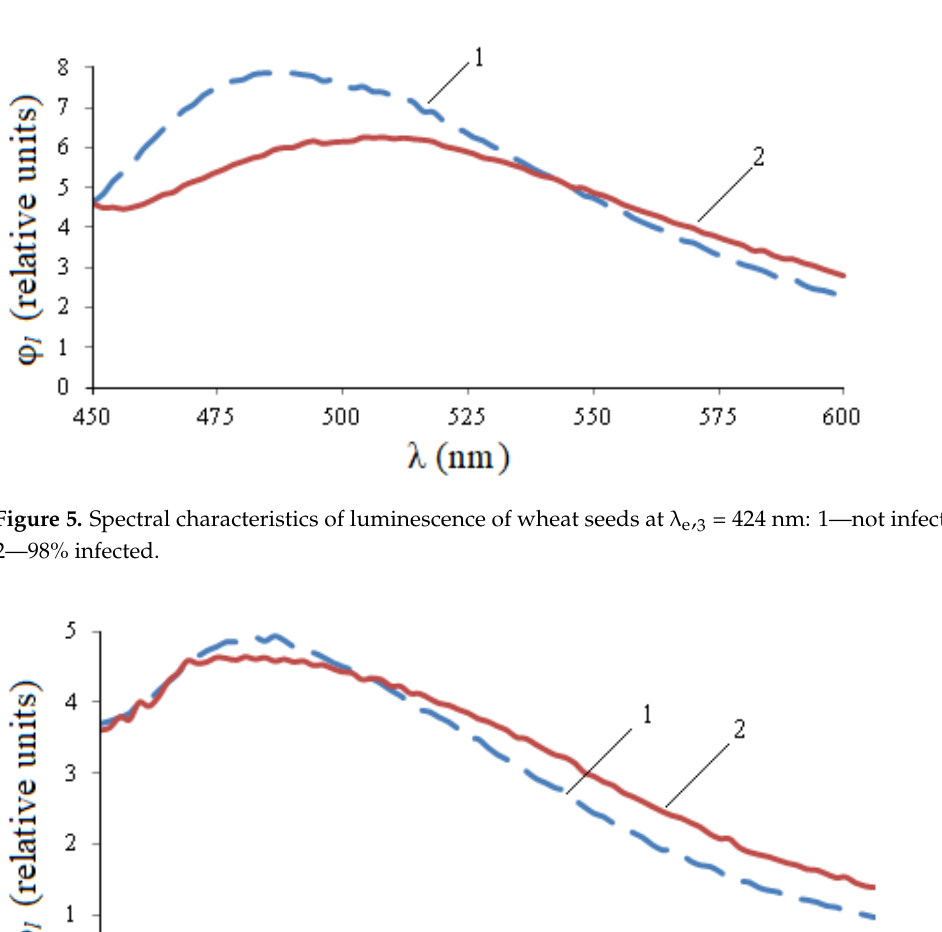
Figure 7. Spectral characteristics of lumi nescence of wheat seeds at λ e , 5 = 528 nm: 1 — not infected, 2 — 98% infected.